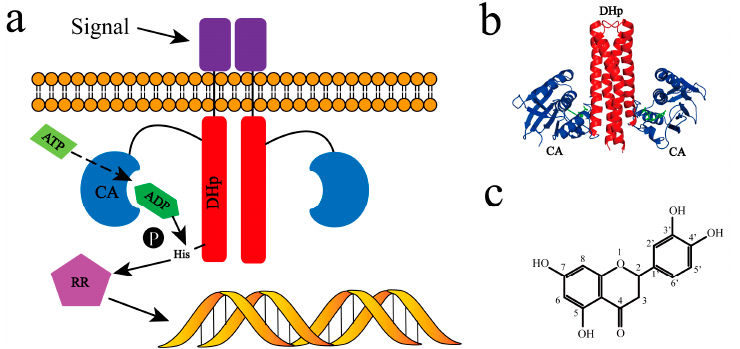
Figure 1. Typical two-component system HK–RR signaling pathway and the potential inhibitor luteolin (Lut). ( a ) The detailed process of signal transduction via histidine kinase (HK) and the downstream response regulator (RR); ( b ) crystal structure of HK853 cp -ADP complex [15]. HK853 DHp was colored in red, HK853 CA in blue, and the two adenosine diphosphate (ADP) molecules in green; ( c ) chemical construction of luteolin.